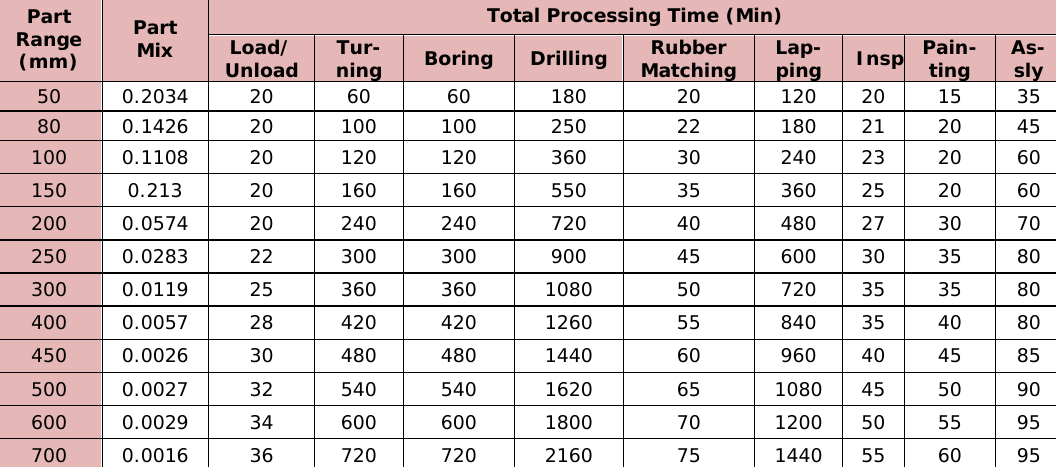
Table 1b. “Concentric Butterfly Valve”. Source: Own